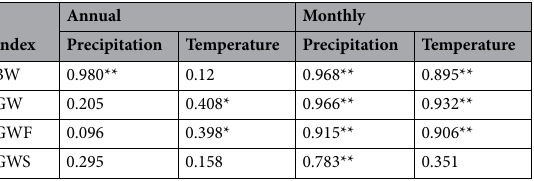
Table 4. Correlations between climate conditions and blue and GW resources on annual and monthly scales.